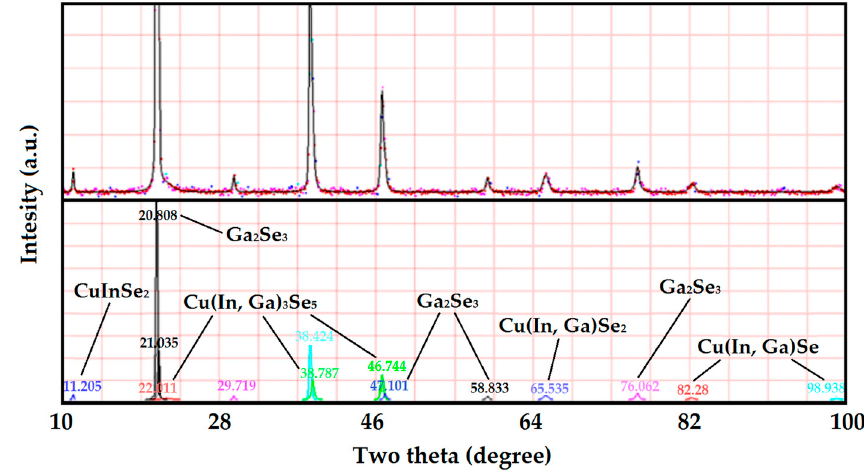
Figure 3. X ‐ ray diffraction (XRD) spectrum of the CIGS layer after selenization, obtained using In 2 Se 3 , Ga 2 Se 3 , and Cu as starting materials.